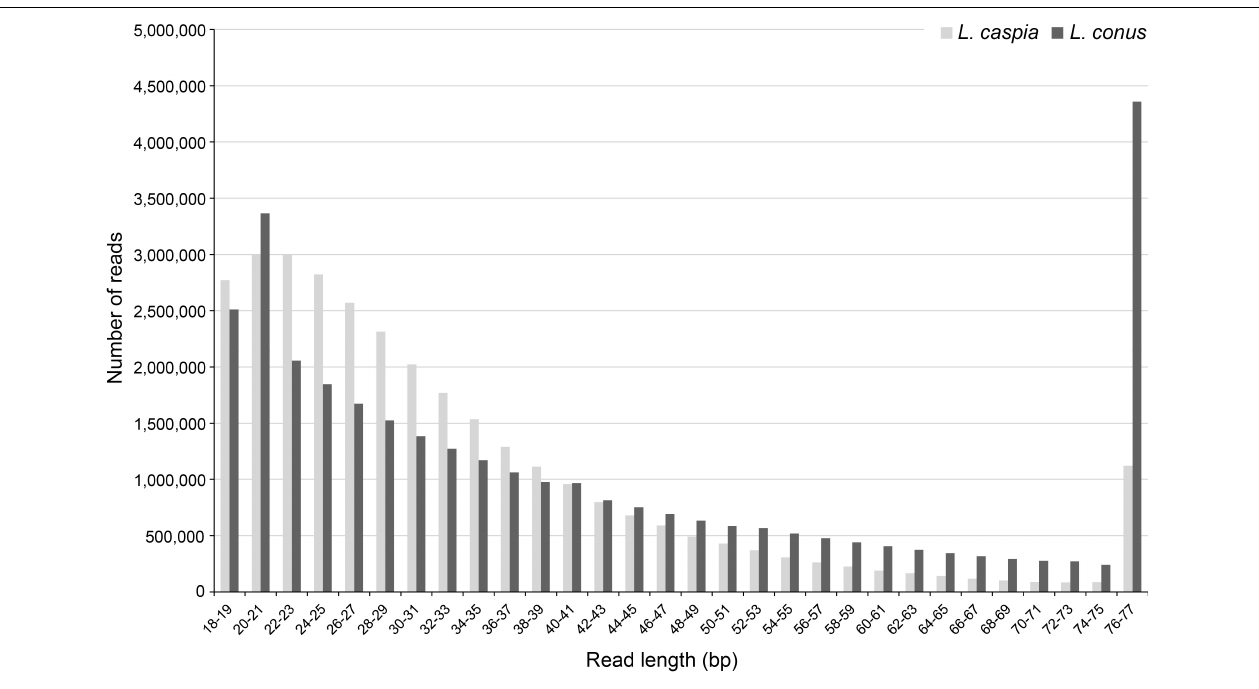
FIGURE 1 | Fragment length distribution (in bp) of trimmed and quality-filtered reads (reduced readpool) of both Laevicaspia